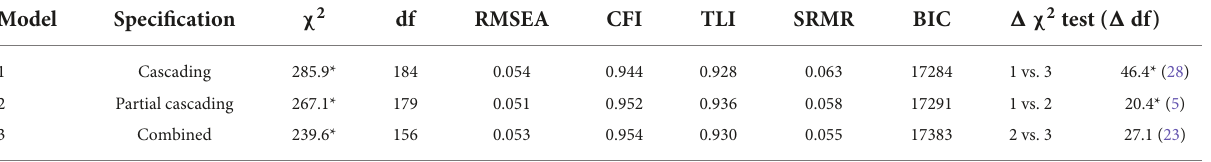
TABLE 2 Fit indices of combined and cascading structural equation models.